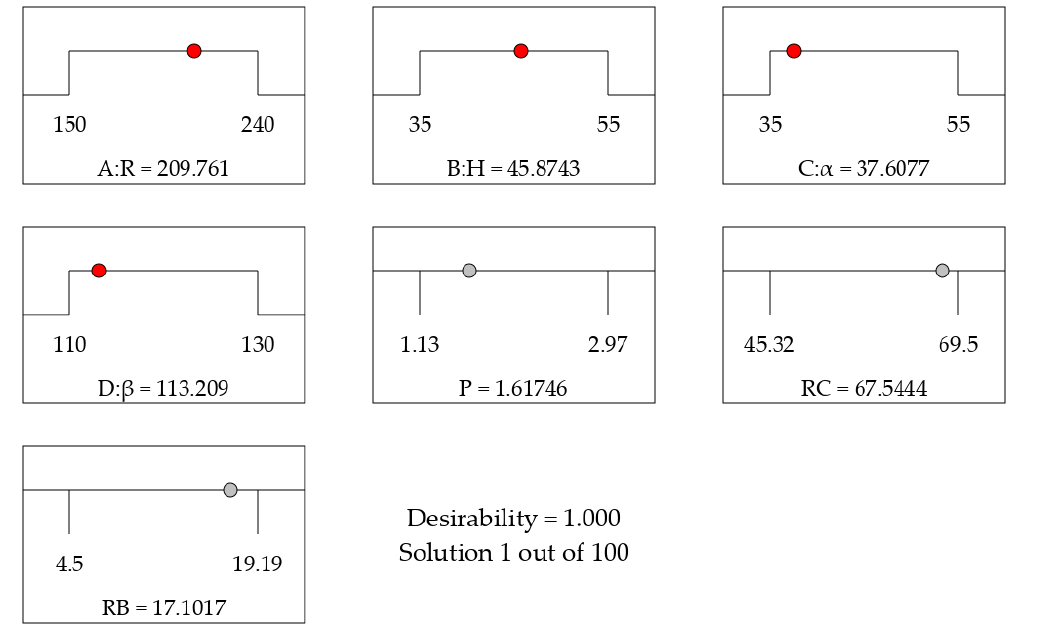
Figure 13. Parameter optimization of theoretical values.